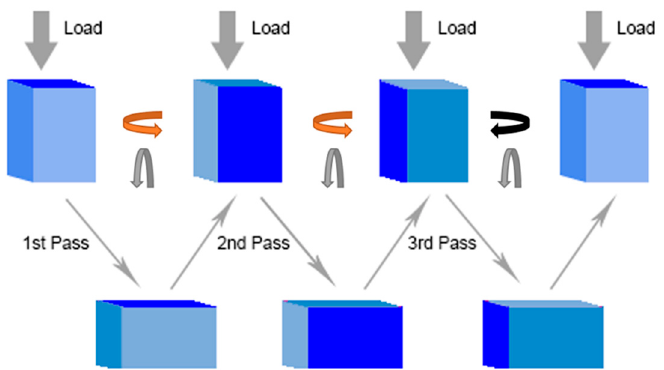
Figure 1. Schematic diagram of multi-axial